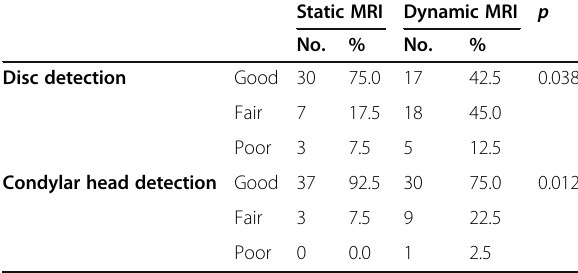
Table 3 Anatomic visibility and detection rate of both articular discs and condylar heads in static and dynamic MRI in the studied patients ( n = 40)